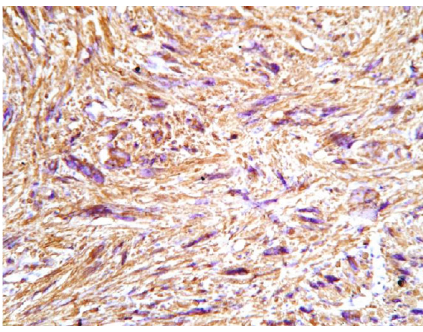
Figure 10: Poorly di ff erentiated malignant mesenchymal tumor. Immunohistochemistry assay with S100 antibodies. Negative reaction in tumor cells